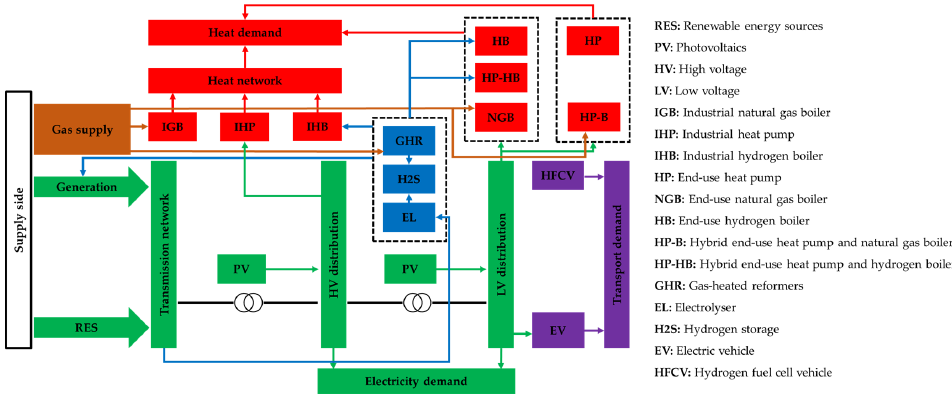
Figure 1. Interaction of integrated electricity–heat–transport–hydrogen system.